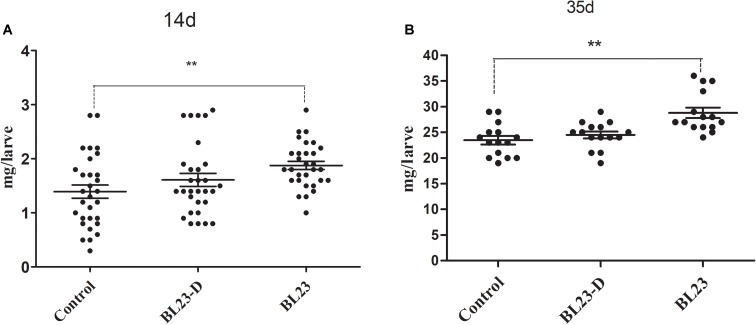
Growth promotion of L. casei BL23 depends on the viability the bacteria cells. The body weight (mg/individual) of zebrafish larvae at 21 (A) dpf and 35 (B) dpf were showed following treated with live or dead cells of L. casei BL23, respectively. The data are shown as mean ± SEM (n = 30 at 14 dpf and n = 15 at 35 dpf, respectively). Data were analyzed using ANOVA test followed by Bonferroni analysis. P-value of ≤0.05 is considered significant difference. One asterisk indicate P < 0.05. Double asterisk indicates P < 0.01.